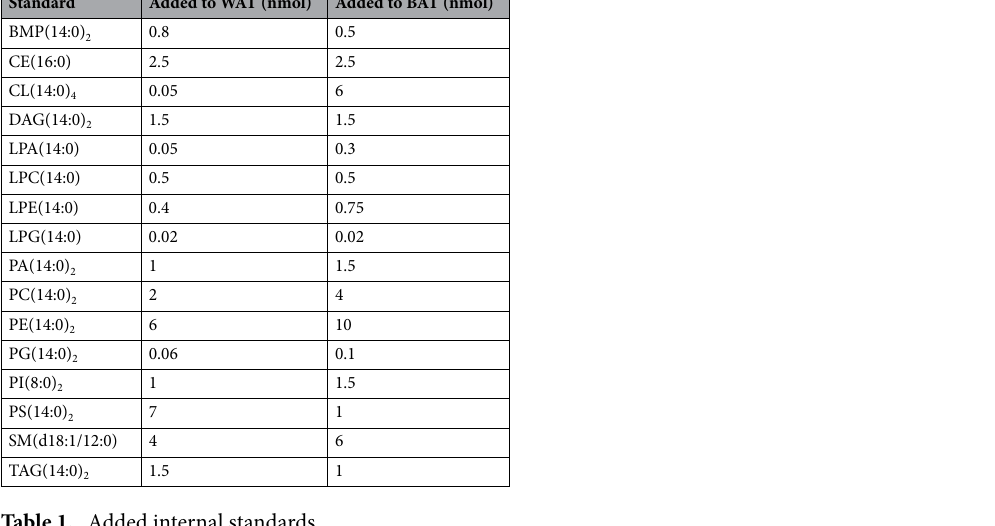
Table 1. Added internal